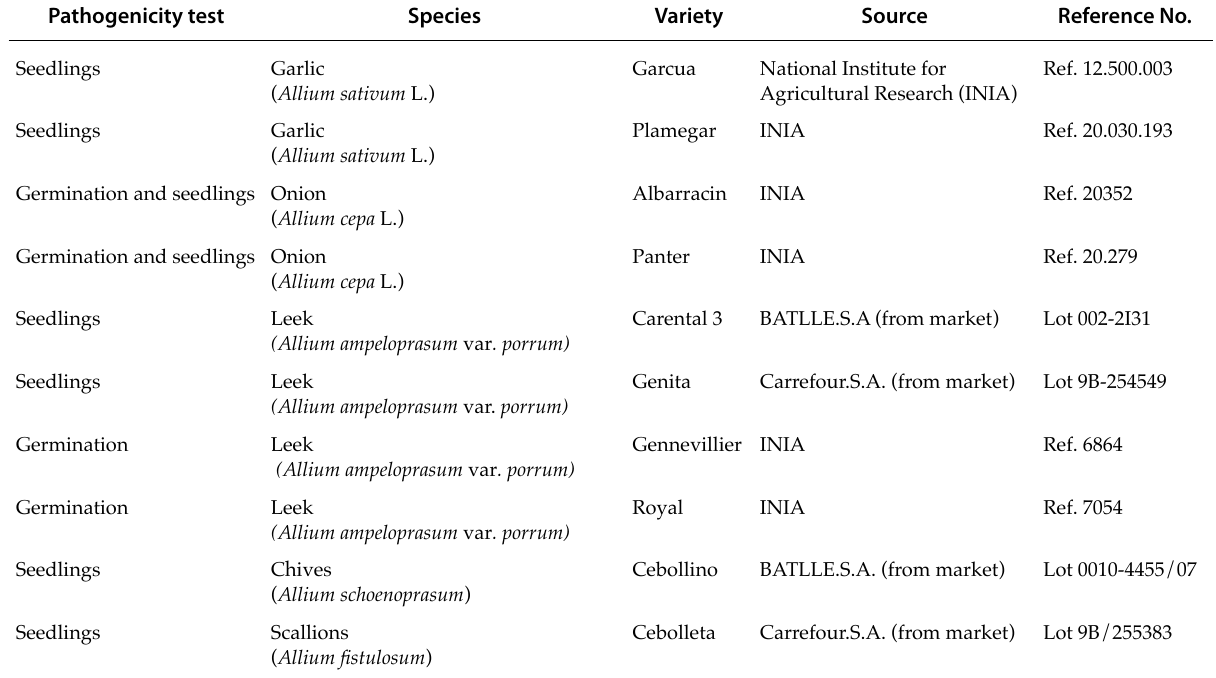
Table 1. Plant material used in pathogenicity